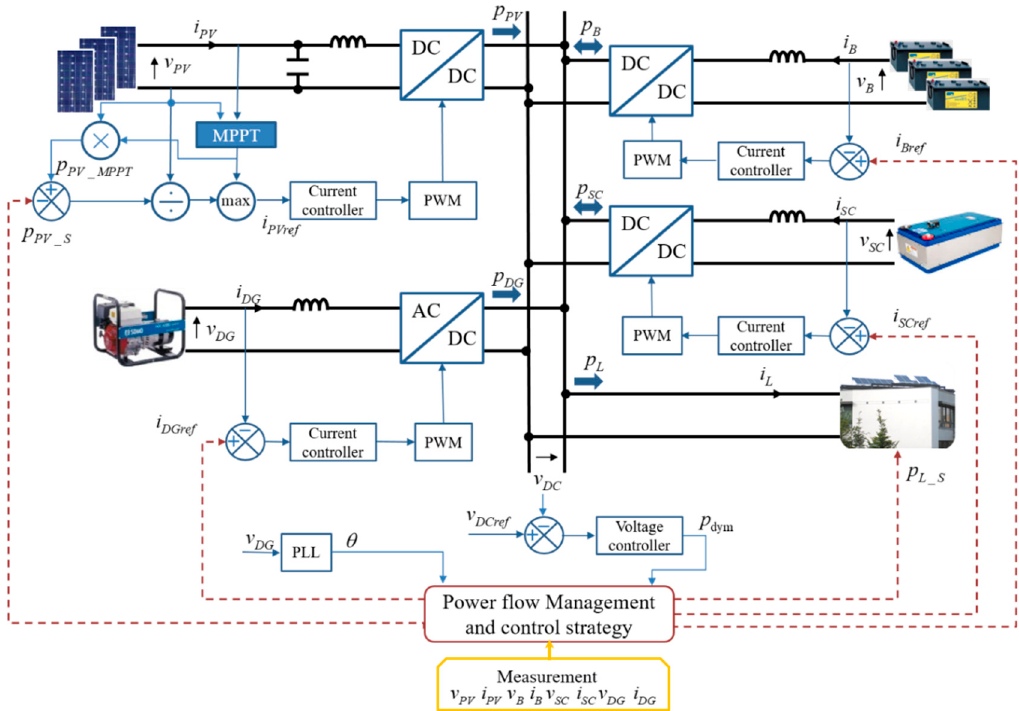
Figure 1. Topology of an autonomous DC microgrid system.